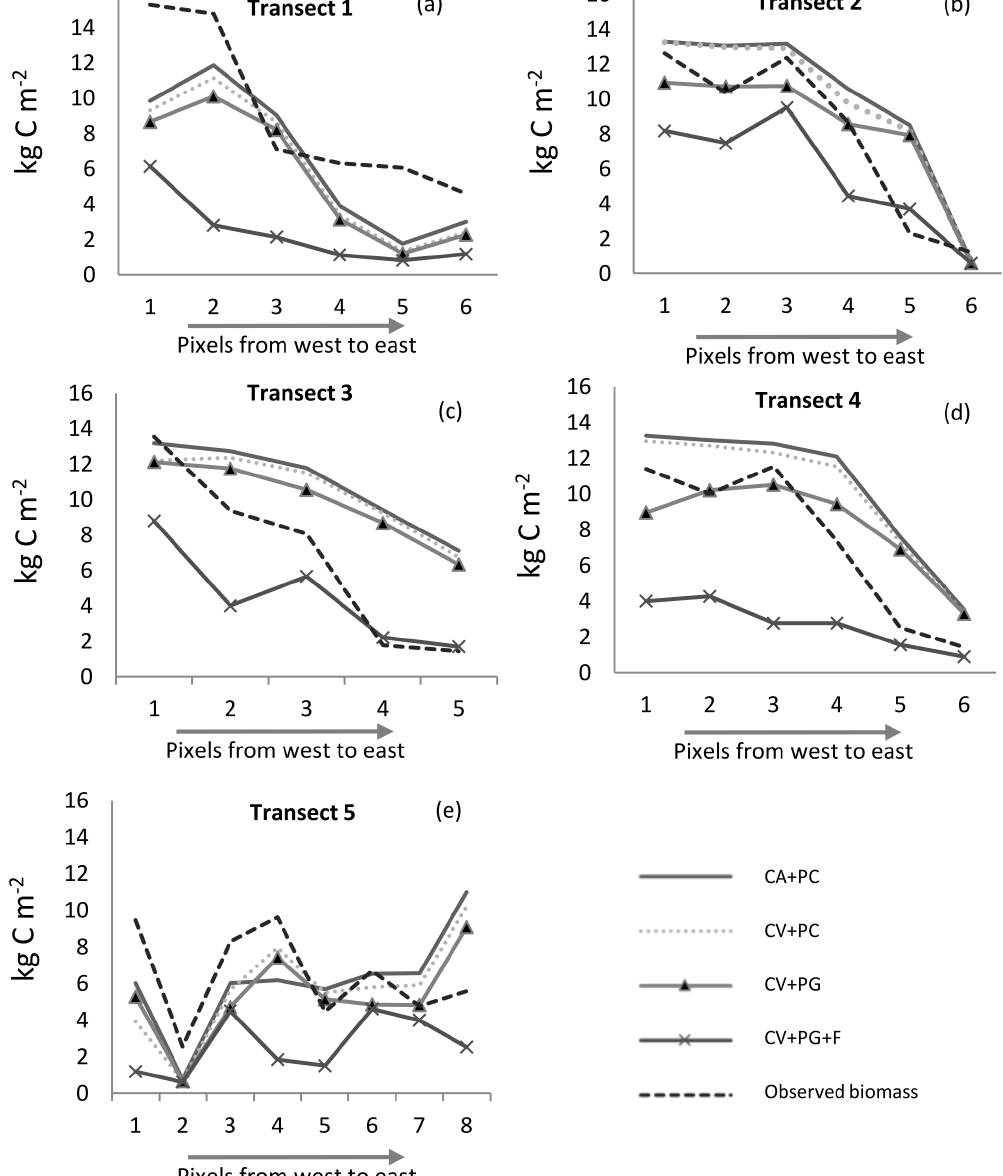
Figure 5. Average longitudinal AGB gradient in the Amazon–Cerrado transition simulated for T1 to T5 (a–e) considering different combi- nations of factors represented in the simulations: seasonal climate simulation (control) (CA + PC); interannual climate variability simulation (CV + PC); interannual climate variability + global P limitation simulation (CV + PG); and interannual climate variability + P limitation + fire occurrence simulation (CV + PG + F). Observed AGB is also shown for comparison with simulation